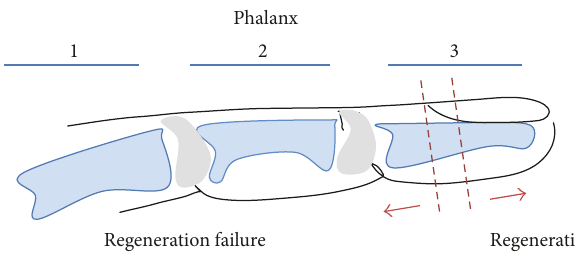
Figure 3: Amputation location affects the ability of digit/appendage to regenerate in mammals. Digit/appendage regrowth only occurs if the amputation site was distal to the middle to the 3rd phalanx, whereas digits amputated 2/3 through the 3rd phalanx do not